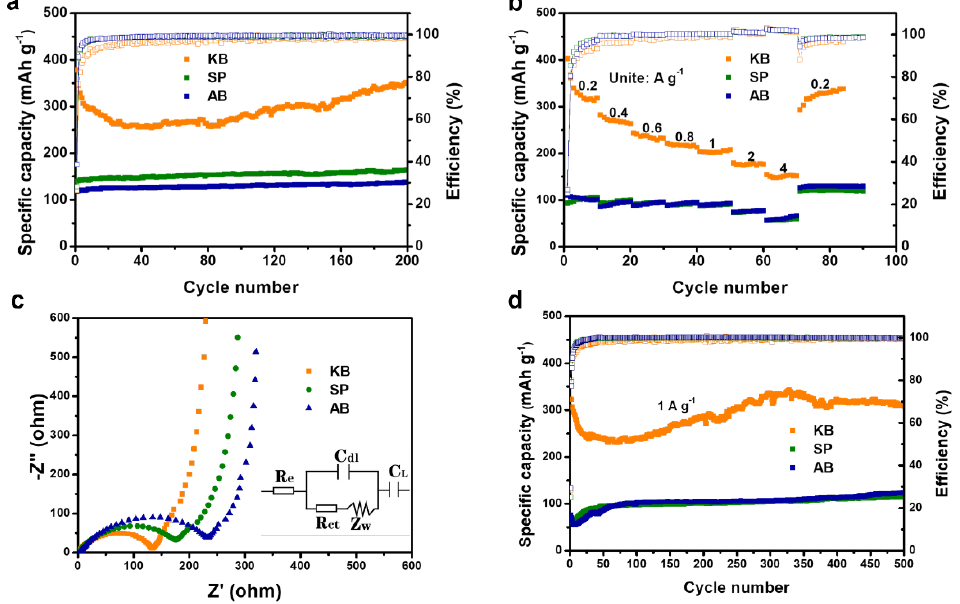
Figure 3. Cycle performance with coulombic efficiency at a current density of 200 mA g −1 ( a ), Rate capability at various current densities ( b ), Nyquist plot ( c ), and long-term cycling performance at a current density of 1.0 A g −1 ( d ) of silica aerogel anode with three carbon conductive agent.